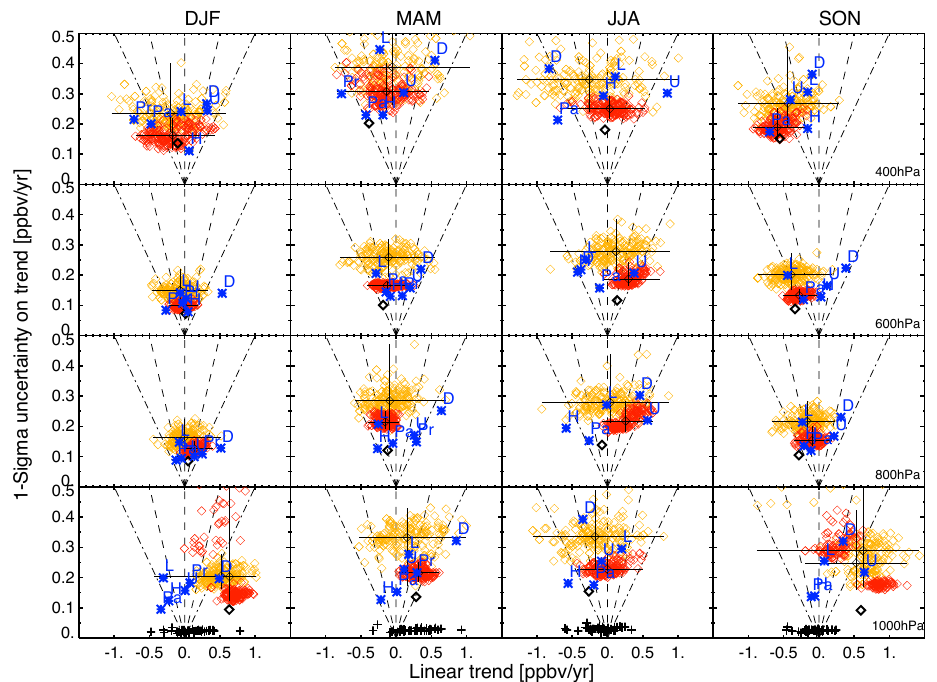
Fig. 6. 1-sigma uncertainty estimate of the linear trend against the linear trend for the four seasons and at four pressure levels (1000, 800, 600, 400hPa, from bottom to top). Black plus symbols give the trends at 48 surface stations. The linear trend is calculated over the period 1998–2008. Blue stars show the trends derived from ozone sondes at the six stations (D=Debilt, H=Hohenpeissenberg, L=Lindenberg, Pa=Payerne, Pr=Praha, U=Uccle) at 1000hPa except for H and Pa, value at 900hPa. The black diamond corresponds to the trends derived from the whole morning MOZAIC data set in Frankfurt. For each frequency, 200 random time series were created from the ensemble of Frankfurt subsamples. The resulting trends are given by the cloud of diamonds in red (frequency of 12 profiles a month) and orange (4 profiles a month). The mean, minimum and maximum of these distributions are shown with the vertical and horizontal black thin lines. The dashed and dot-dashed lines show the 67% and 95% confidence limit lines for the